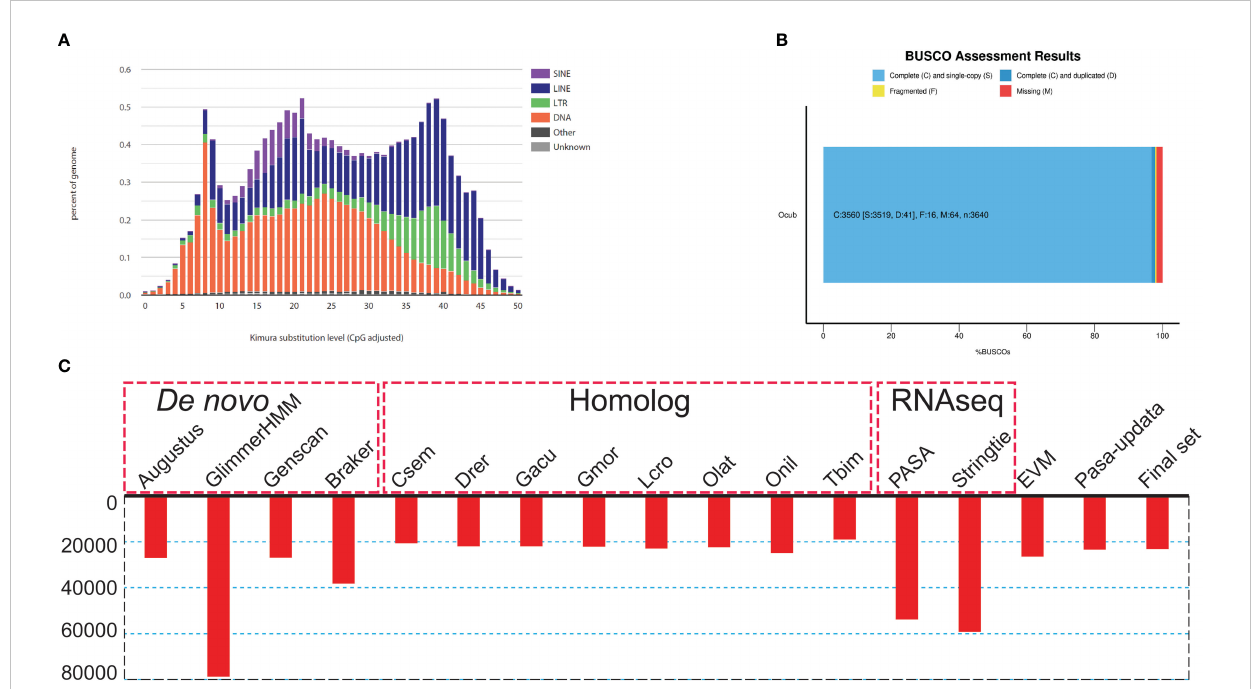
FIGURE 2 Genome assembly and annotation information. (A) Kimura distance-based copy divergence analysis of transposable elements in O. cubicus genome. Graphs represent genome coverage (Y-axis) for each type of TE (SINE, LINE, LTR retrotransposons and DNA transposons) in the genome analyzed, clustered to its corresponding consensus sequence according to Kimura distances (X-axis, K-value from 0 to 50). (B) BUSCO evaluation results, 97.3% classi fi ed as “ complete and single-copy ” , 1.3% as “ complete and duplicated ” and 0.2% as “ fragmented ” BUSCOs were present in the O. cubicus assembly genome. (C) Summary statistics of the identi fi ed protein-coding genes by using different strategies, including de novo prediction, homology-based prediction, and transcriptome-based